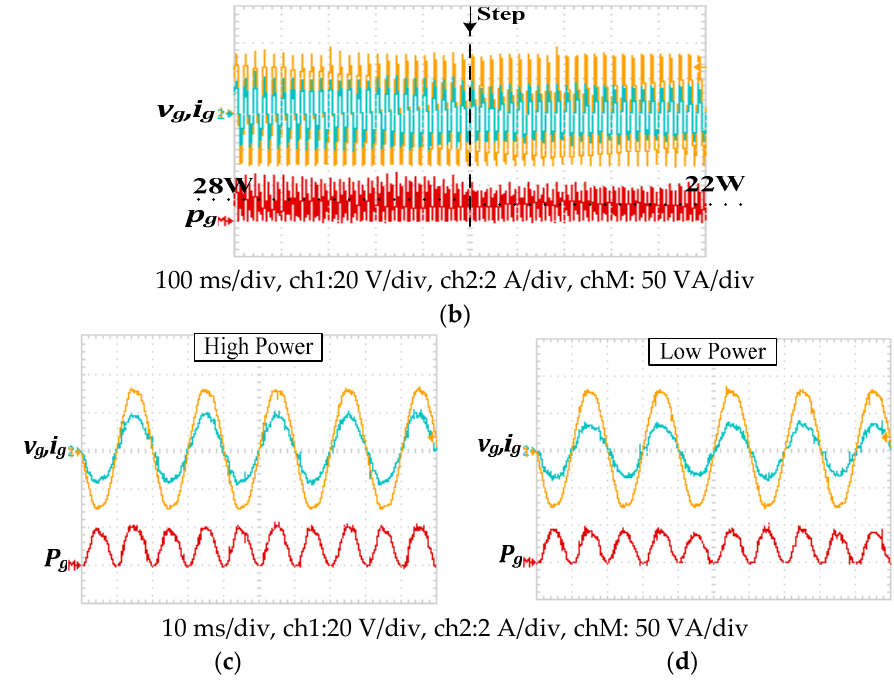
Figure 7. System performance applying PCHC, grid voltage THD = 3.9%. ( a ) PV voltage, current and power, ( b ) Grid voltage, current and power, ( c , d ) zoom of Grid voltage, current and power at high and low power levels respectively.